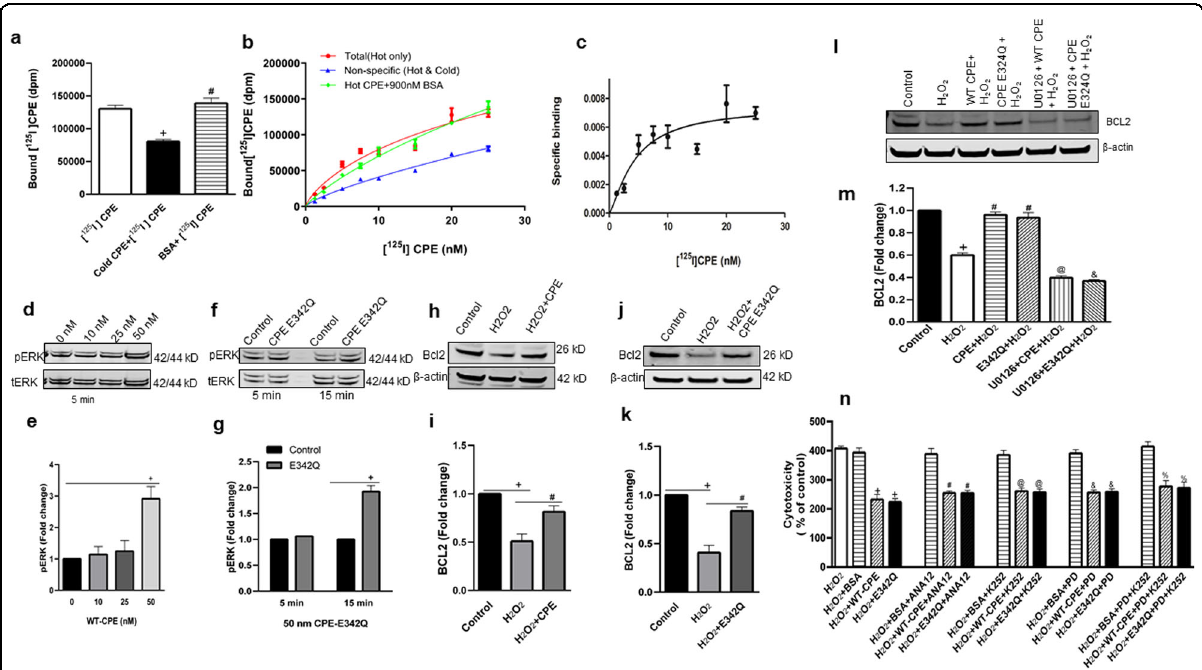
Fig. 5 CPE binds to cell surface membrane and activates ERK-BCL2 signaling cascade, and its neuroprotective effect is tyrosine kinase independent. a [ 125 I] CPE binds speci fi cally to HT22 cell surface. HT22 cells were incubated with 25nM [ 125 I] radio-labeled CPE (hot) for 3h on ice in serum- free binding medium. To demonstrate binding speci fi city, 900nM non-radio-labeled CPE (cold) or bovine serum albumin (BSA) was co-incubated with hot CPE to compete and displace the hot CPE binding. The bar graphs show that the [ 125 I] CPE binding to HT22 cell surface membrane was displaced by cold CPE but not by BSA. One-way ANOVA followed by Tukey ’ s post hoc multiple comparison test, [ F (2,6) = 29.11, p = 0.0008]. + p = 0.002 for cold CPE + [ 125 I] CPE compared with [ 125 I] CPE (hot) treatment; # p = 0.001 for BSA + [ 125 I] CPE compared with CPE (cold) + [ 125 I] CPE treatment. The experiment was run in triplicates, values are mean ± SEM. b [ 125 I] CPE binds HT22 cell surface in a saturated manner. HT22 cells were incubated with different concentrations (1.25 – 25nM) of [ 125 I] CPE (hot) with or without 900nM cold CPE for 3h on ice in serum-free binding medium. The non-speci fi c binding was determined by measuring bound [ 125 I] CPE in the presence of excess non-radio-labeled CPE (cold) with the [ 125 I] CPE. Note that BSA did not displace total [ 125 I] CPE binding. c Graph shows speci fi c binding obtained by subtracting non-speci fi c binding from total [ 125 I] CPE binding. d – g CPE and CPE-E342Q activate ERK signaling in HT22 cpe − / − neuronal cells. d HT22 cpe − / − cells were treated with 0, 10, 25, and 50nM WT-CPE for 5min and pERK 1/2 were analyzed by western blotting. e Bar graphs showing the fold change in phosphorylation of ERK1/2 which was determined by normalization using tERK1/2 as an internal control. One-way ANOVA analysis followed by Tukey ’ s post hoc multiple comparison test, [ F (3, 8) = 9.830, p = 0.0046]. + p = 0.0065 for 50nM WT-CPE compared with control at 0nM concentration. N = 3, values are mean ± SEM. f HT22 cpe − / − cells were treated with 50nM CPE-E342Q for 5min and 15min and pERK 1/2 were analyzed by western blotting. g Bar graphs showing the fold change in phosphorylation of ERK1/2 which was determined by normalization using tERK1/2 as an internal control. One-way ANOVA analysis followed by Tukey ’ s post hoc multiple comparison test, [ F (3,8) = 61.33, p <0.0001]. + p <0.0001 for CPE-E342Q treatment compared with control at 15min. N = 3, values are mean ± SEM. h – k CPE and CPE-E342Q protect HT22 cpe − / − cells against oxidative stress by regulating BCL2 level. h , j Western blot analysis of BCL2 protein in HT22 cpe − / − cells which were treated with CPE-WT or CPE-E342Q respectively for 6h followed by 100 μ M H 2 O 2 for 18 – 24h. i , k Bar graphs showing quanti fi cation of BCL2 protein after normalization with β -actin which was used as a loading control. Results are expressed as fold change as compared to untreated controls. Similar to WT-CPE protein, CPE-E342Q was also able to prevent the H 2 O 2 induced decrease in BCL2 level. For CPE-WT( i ): one-way ANOVA analysis followed by Tukey ’ s post hoc multiple comparison test, [ F (2, 6) = 19.37, p = 0.0024]. + p = 0.002 for H 2 O 2 compared to untreated control, # p = 0.0201 for H 2 O 2 + CPE compared to H 2 O 2 treatment. N = 3, values are mean ± SEM. For CPE-E342Q ( k ): one-way ANOVA analysis followed by Tukey ’ s post hoc multiple comparison test, [ F (2, 6) = 38.69, p = 0.0004]. + p = 0.0004 for H 2 O 2 treatment compared to control, # p = 0.002 for H 2 O 2 + E342Q compared to H 2 O 2 treatment. N = 3, values are mean ± SEM. l, m Effect of ERK inhibitor on CPE induced BCL2 expression. l Western blot analysis of BCL2 protein in HT22 cpe − / − cells which were treated with or without 5 μ M MEK 1/2 inhibitor, U0126 for 30min followed by treatment with 50nM WT or E342Q recombinant CPE for 6h. Cells were then treated with 100 μ M H 2 O 2 for the next 24h. m Bar graphs showing quanti fi cation of BCL2 protein after normalization with β -actin which was used as a loading control. Results are expressed as fold decrease as compared to untreated controls. One-way ANOVA analysis followed by Tukey ’ s post hoc multiple comparison test, [ F (5,12) = 138.6, p <0.0001]. + p <0.0001 for H 2 O 2 compared to control, # p <0.0001 for both CPE + H 2 O 2 and E342Q + H 2 O 2 compared with H 2 O 2 treatment, @ p <0.0001 for U0126 + CPE + H 2 O 2 compared with CPE + H 2 O 2 treatment, & p <0.0001 for U0126 + E342Q + H 2 O 2 compared with E342Q + H 2 O 2 treatment . N = 3, values are mean ± SEM. n Neuroprotective effect of WT-CPE and CPE-E342Q against H 2 O 2 -induced cytotoxicity in mouse primary hippocampal neurons is independent of Trk receptor signaling. Bar graphs show that, 1µM of Trk inhibitor, K-252a, or 100µM of ANA12, a speci fi c TrkB inhibitor, or 1µM of FGFR1,2,3 inhibitor, PD166285 did not inhibit the neuroprotective effect of CPE and CPE-E342Q against H 2 O 2 -induced cytotoxicity assessed by LDH assay. One-way ANOVA analysis followed by Tukey ’ s post hoc multiple comparison test, [ F (15,32) = 26.93, p <0.0001]. + p <0.0001 for H 2 O 2 + WT-CPE and H 2 O 2 + E342Q compared with H 2 O 2 + BSA; # p <0.0001 for H 2 O 2 + WT-CPE + ANA12 and H 2 O 2 + E342Q + ANA12 compared with H 2 O 2 + BSA + ANA12; @ p <0.0001 for H 2 O 2 + WT-CPE + K252 and H 2 O 2 + E342Q + K252 compared with H 2 O 2 + BSA + K252; & p <0.0001 for H 2 O 2 + WT-CPE + PD and H 2 O 2 + E342Q + PD compared with H 2 O 2 + BSA + PD; % p <0.0001 for H 2 O 2 + WT-CPE + PD + K252 and H 2 O 2 + E342Q + PD + K252 compared with H 2 O 2 + BSA + PD + K252 treatment. N = 3 independent experiments which were run in triplicate, values are mean ±